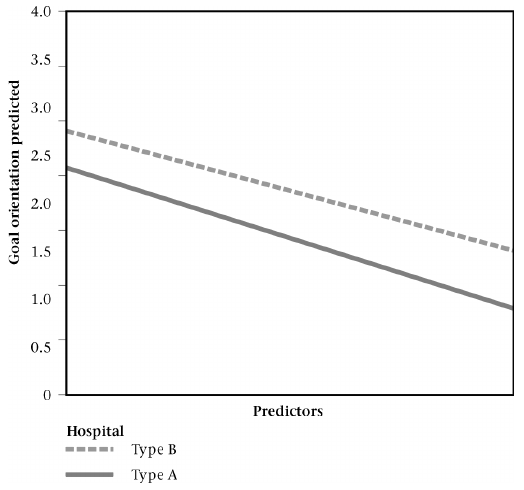
Figure 2: Predictors of Goal Directedness (GD)